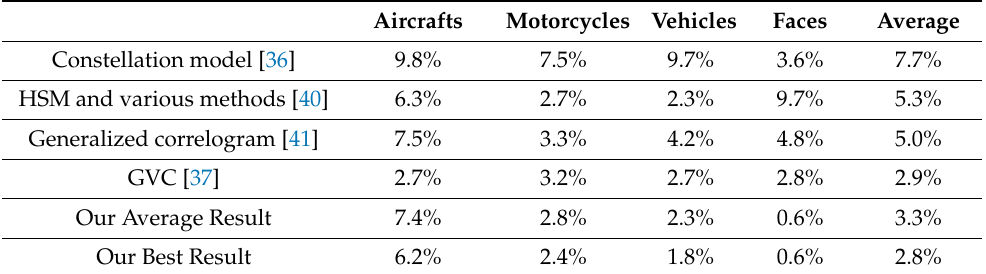
Table 6. Enhanced result (error rate) of combination with external aircraft model in